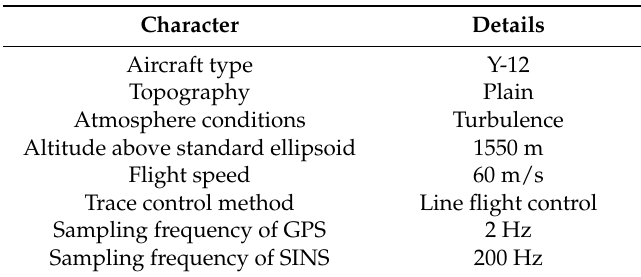
Figure 14. Trajectory of Neimeng flight.